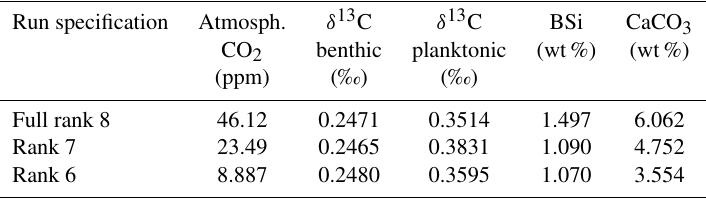
Table 7. Average root mean square deviation of the optimised modelled tracer records (as estimated from the simultaneous fit of the sensitivity experiment results to the observations) from the simulated control run tracer record. A zero value would mean that no difference with respect to the control run has occurred. The larger the values, the more the optimised tracer curves and the control run tracer curves differ (a value of zero would mean that there is no change between the result from the fitting procedure and the control